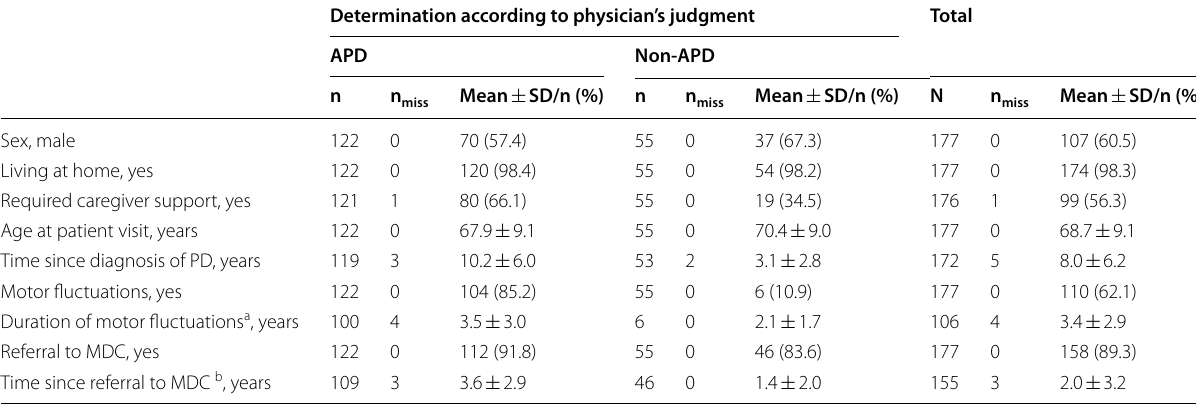
APD, advanced Parkinson’s disease; MDC, movement disorder center; n miss : number of missing values; PD, Parkinson’s disease a Restricted to patients with motor fluctuations, b Restricted to patients referred to